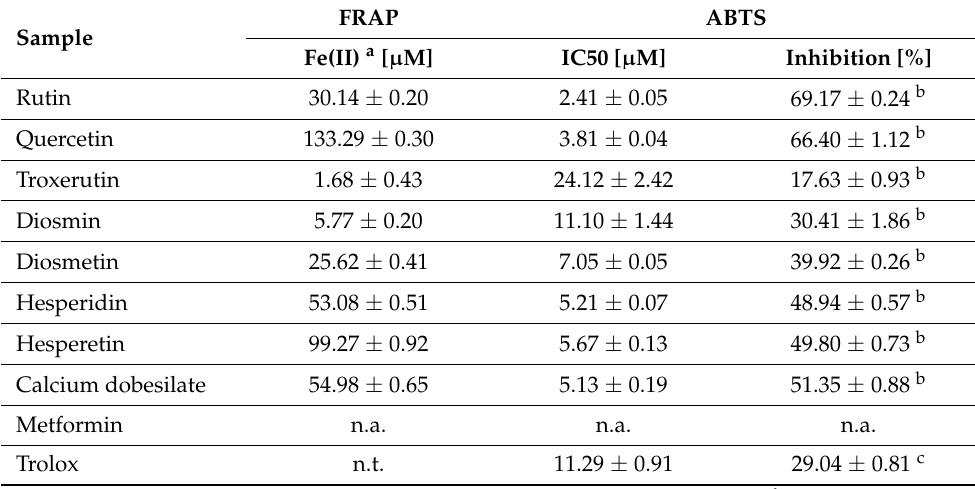
Table 1. Antioxidant activity of selected vasoprotectives and their structural analogs compared to